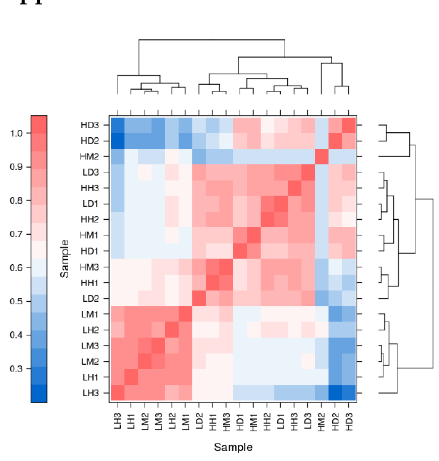
Figure A1. Correlation analysis chart of A. hyacinthus . Based on gene expression of each group of samples. Colors represent the correlation between different samples. Lines represent the functional relationships between different samples.